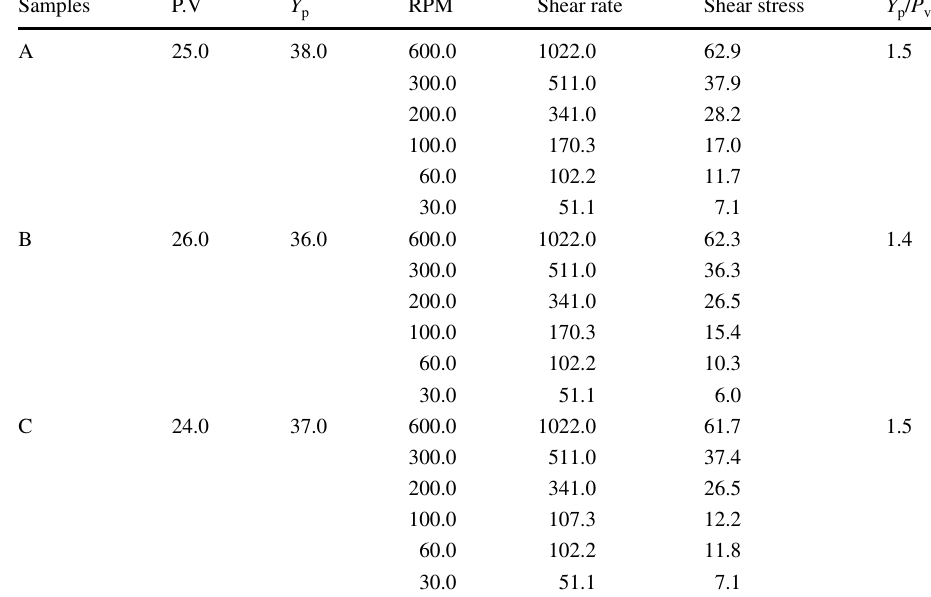
Table 17 Rheology property of the proposed viscosifier at 15 g